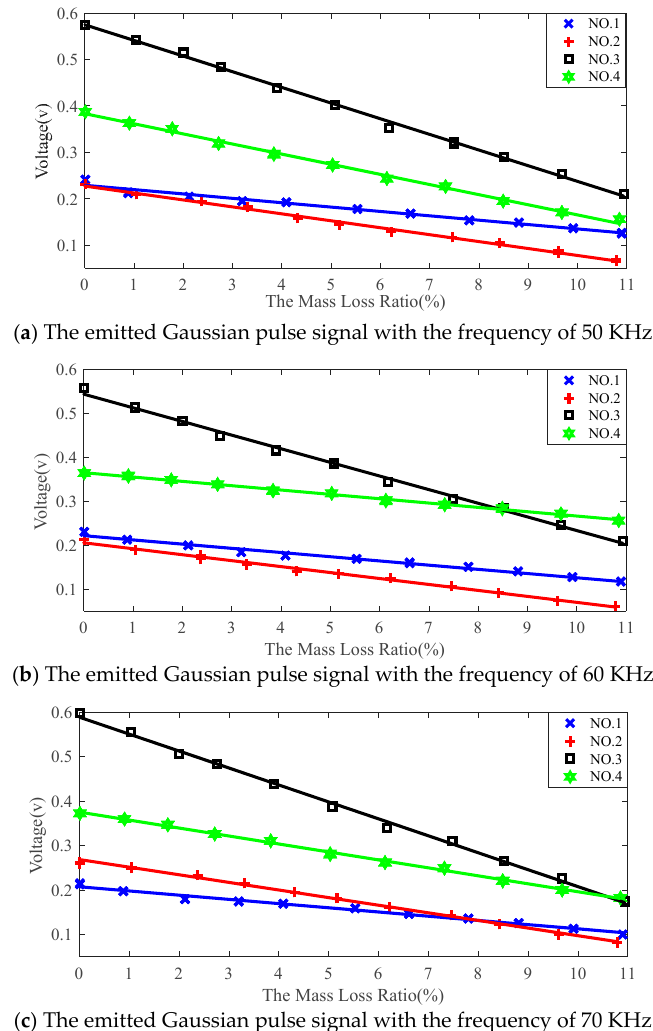
Figure 13. The amplitude of focused signal with mass loss ratio of different specimens.